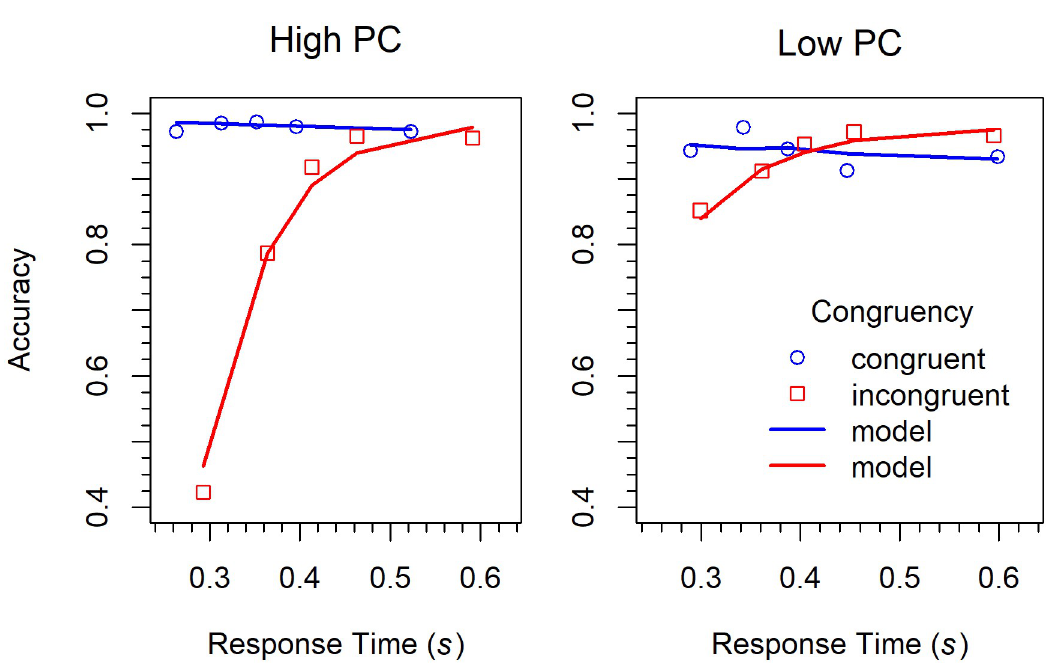
Fig 15. Conditional accuracy functions for the different conditions in Experiment 3 (Simon task) and the fit (lines) of the DSTP model.